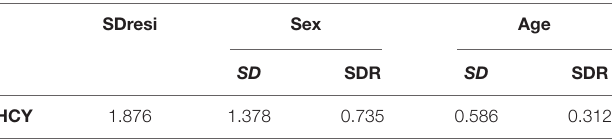
TABLE 3 | SDR of sex and age.